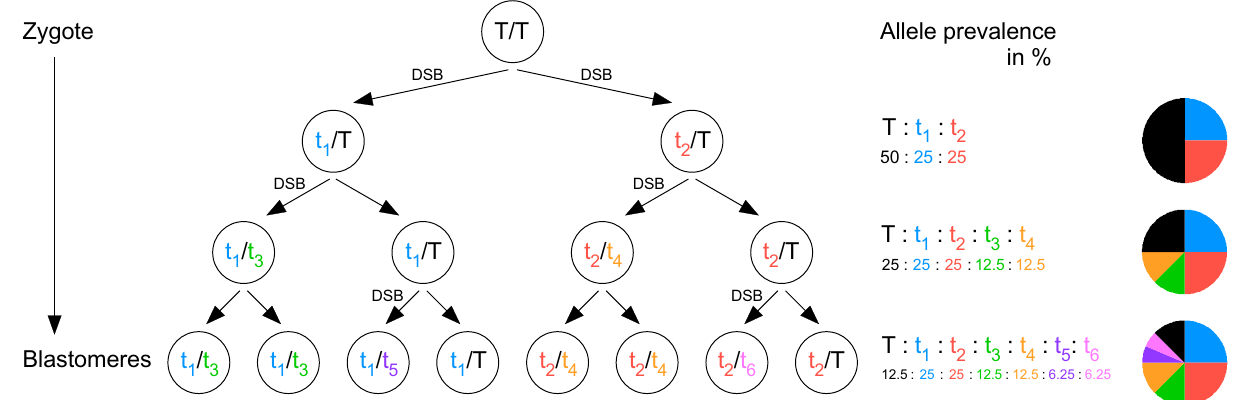
Figure 9. Successive CRISPR-induced mutations during the first embryonic cell divisions. Depicted is the most parsimonious theoretically possible scenario by which 6 mutant alleles in the same individual can be induced. T: wildtype allele, t 1–6 : different mutant alleles (separate colors). As cells divide, DNA strand breaks (DSB) can occur on either sister chromatid, with retention of wildtype allele on the intact strand. The different alleles will be represented at different prevalence among all cells in successive generations, as visualized in the pie diagrams (colors correspond to the respective mutant alleles t 1–6